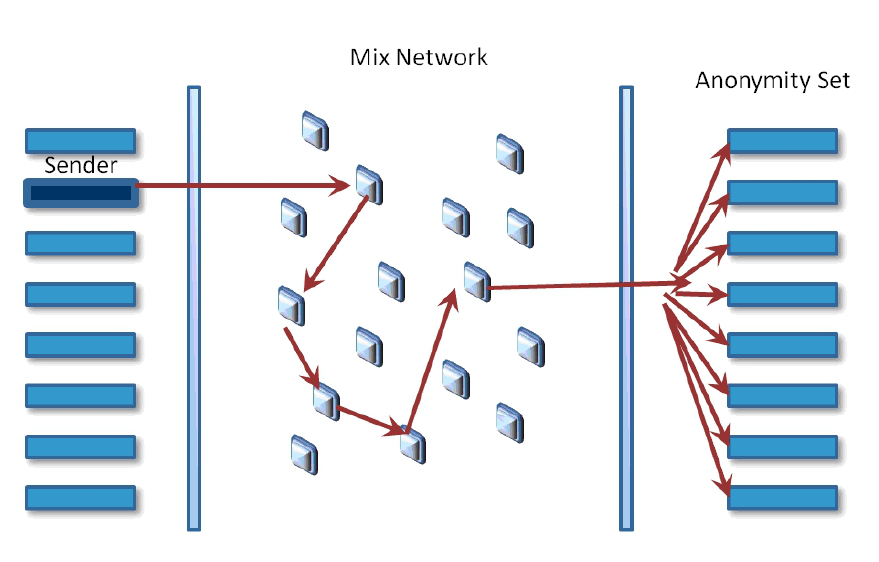
Figure 1. Mix network